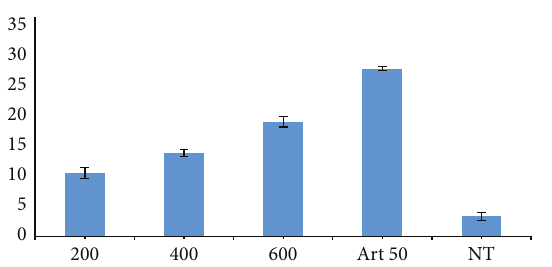
Figure 5: Mean survival time of P. berghei-infected mice. NT: not